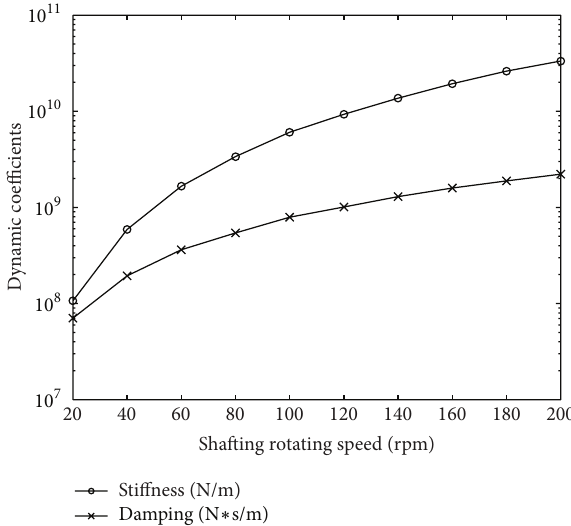
Figure 6: Stiffness and damping of oil